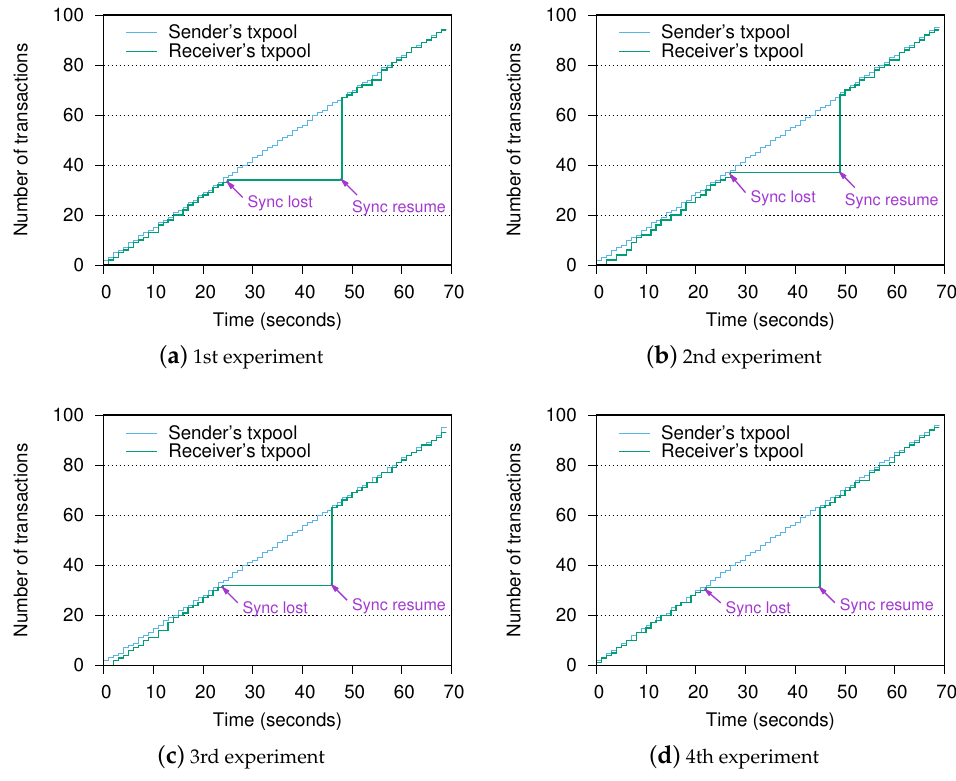
Figure 3. Experimental results of recovery